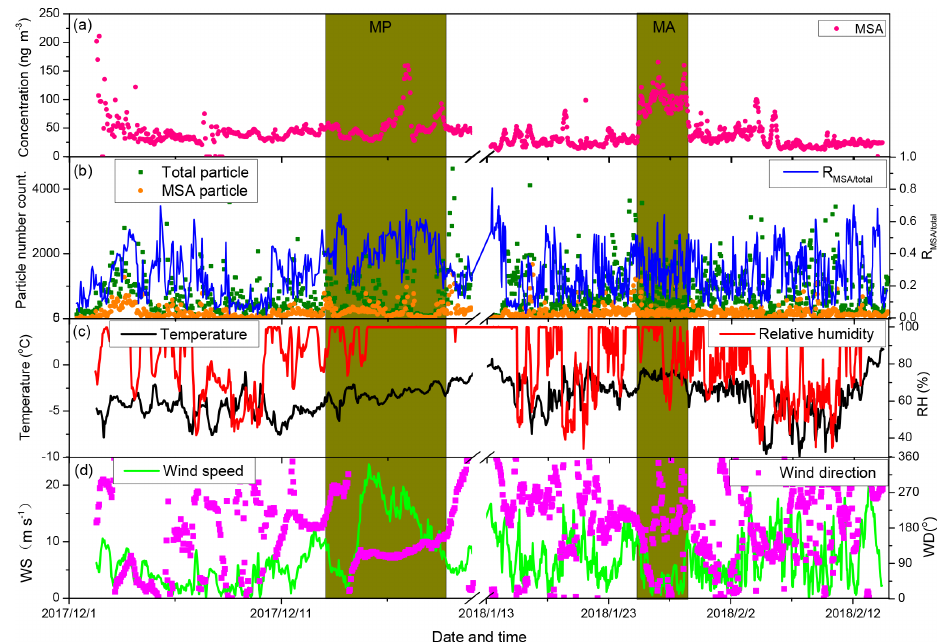
Figure 2. Relationship between MSA mass concentration and MSA particle population in the context of various environmental factors. (a) Time series of MSA mass concentrations; (b) time series of MSA particle population, total particle population, and the ratio of MSA particle population and total particle population; (c) time series of temperature and relative humidity (RH); and (d) time series of wind speeds and